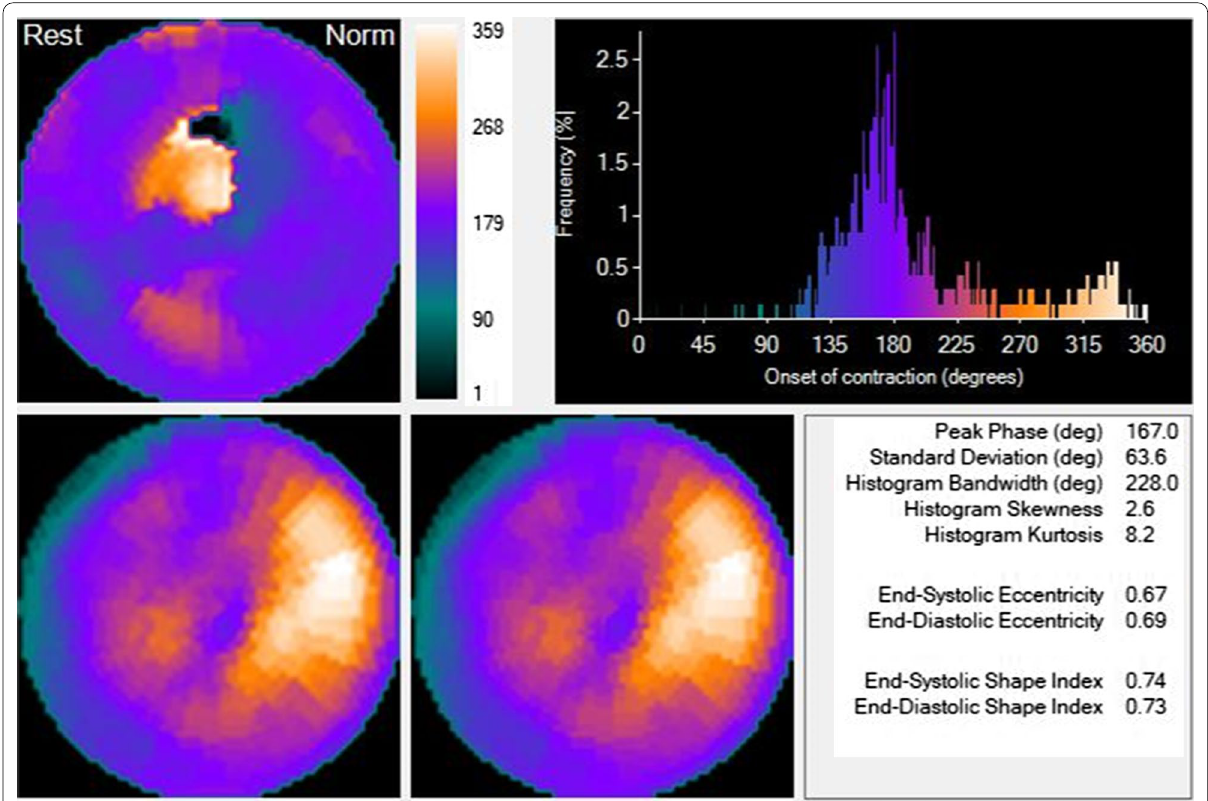
Fig. 3 Same patient, intraventricular synchronism behavior pre-CRT. There is a marked dyssynchrony. CRT cardiac resynchronization therapy, HBW histogram bandwidth, PSD phase histogram standard